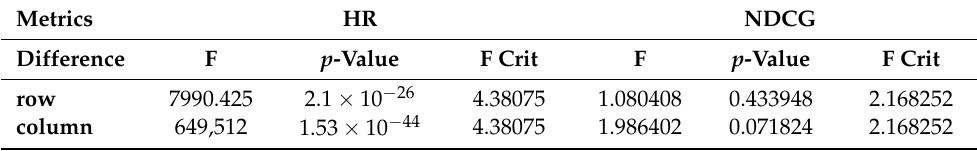
Table 3. The results of statistical significance tests with HR and NDCG on